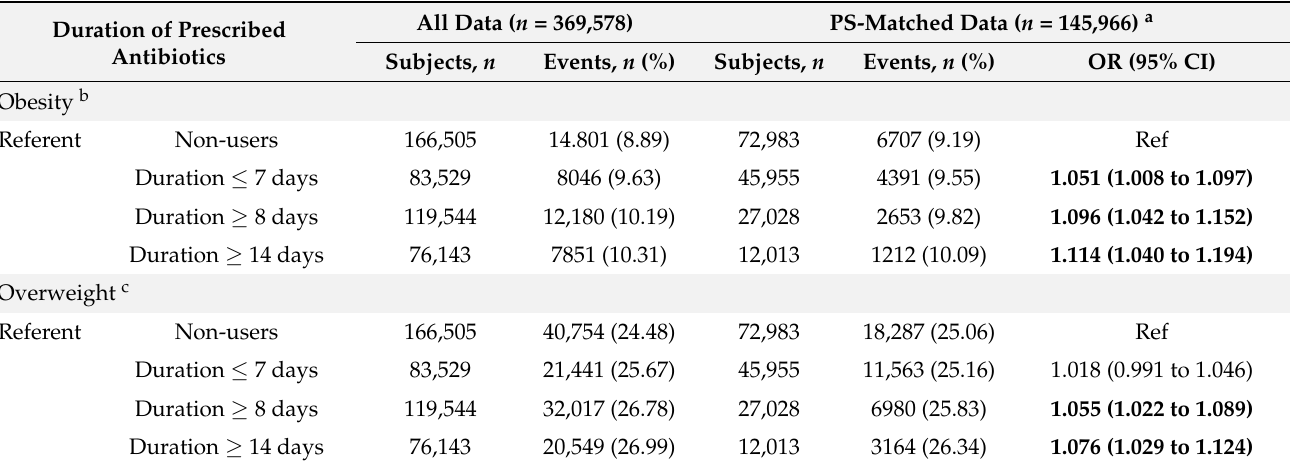
Table 5. The duration-dependent effect of antibiotic use on overweight and obesity in children. All Data ( n =